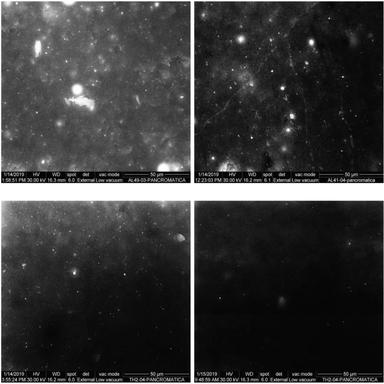
Representative panchromatic CL images: TOP: black glaze – AL49 (left) and brown glaze – AL41 (right) of the Hellenistic archaeological pottery samples; BOTTOM: black glaze – TH1 (left) and brown glaze – TH2 (right) of the 'authentic' replicas.